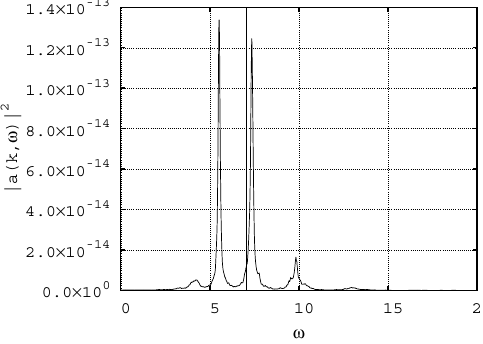
Figure 19. Spectral line of the harmonic k = (0, 150). The conden- sate was present.